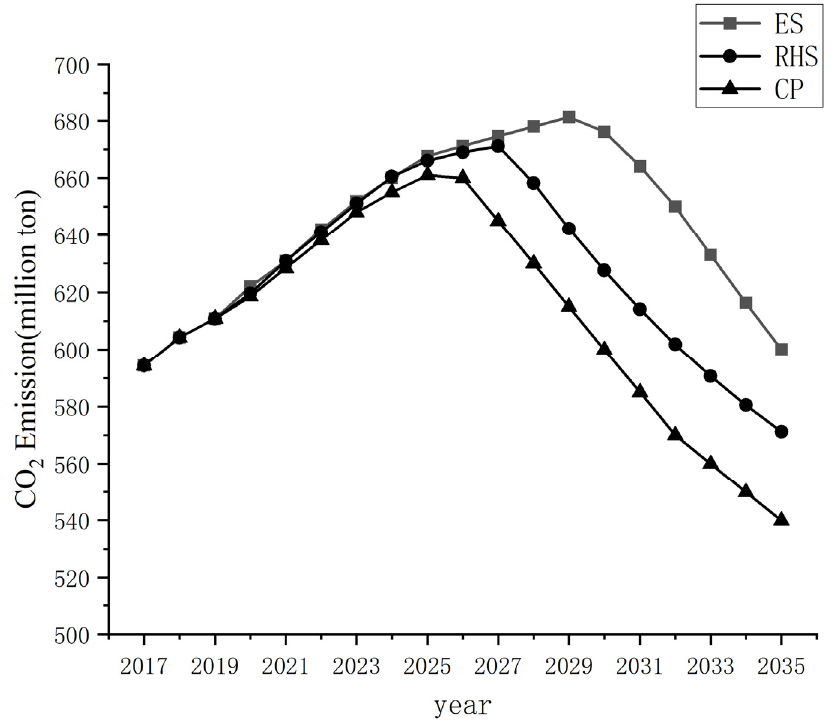
Figure 3. total carbon dioxide emissions under different scenarios. Figure 3. Total carbon dioxide emissions under different scenarios.